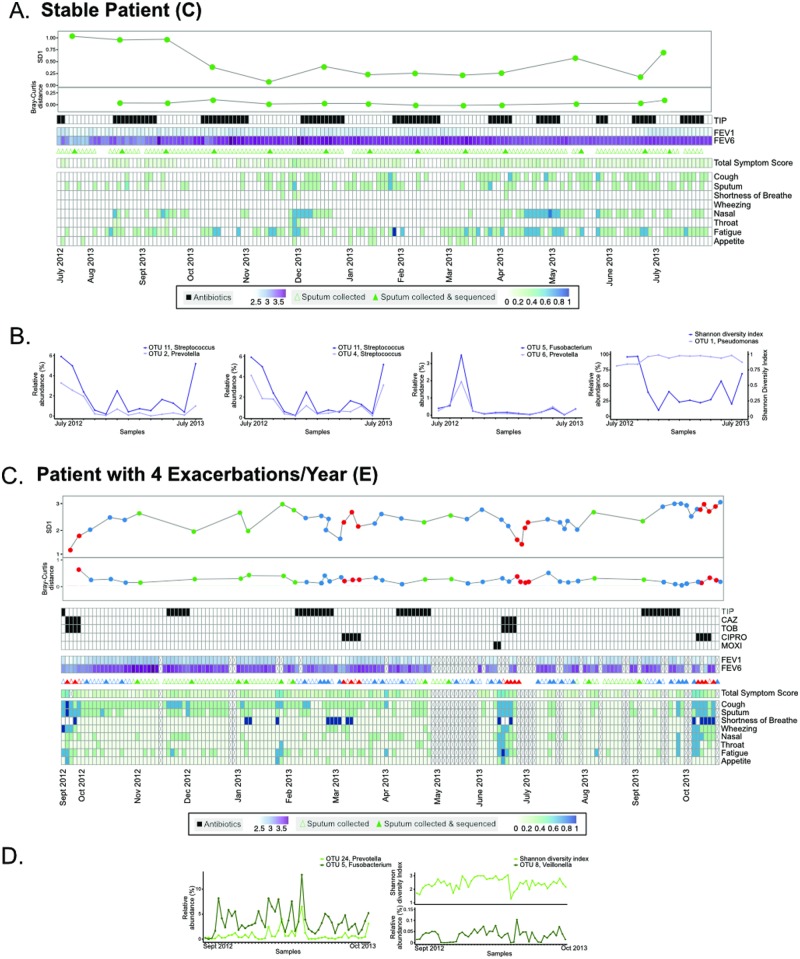
Longitudinal dynamics of two select participants (C and E).Two participants who were the outliers in terms of the number of pulmonary exacerbations experienced over the course of the study period were chosen for closer examination. A. Sample collection for participant C is shown in relation to, antibiotic use, FEV1, and symptom scores. B. Correlations between collected data, diversity metrics, and OTU relative abundance were calculated and significant correlations were reported (S4 Table); a subset of these significant correlations are plotted. C. Sample collection for participant E in relation to antibiotic use, FEV1, and symptom scores. D. Correlations between these collected data and the OTUs present within the microbiome were calculated and significant correlations were reported (S5 Table); a subset of these significant correlations are plotted.